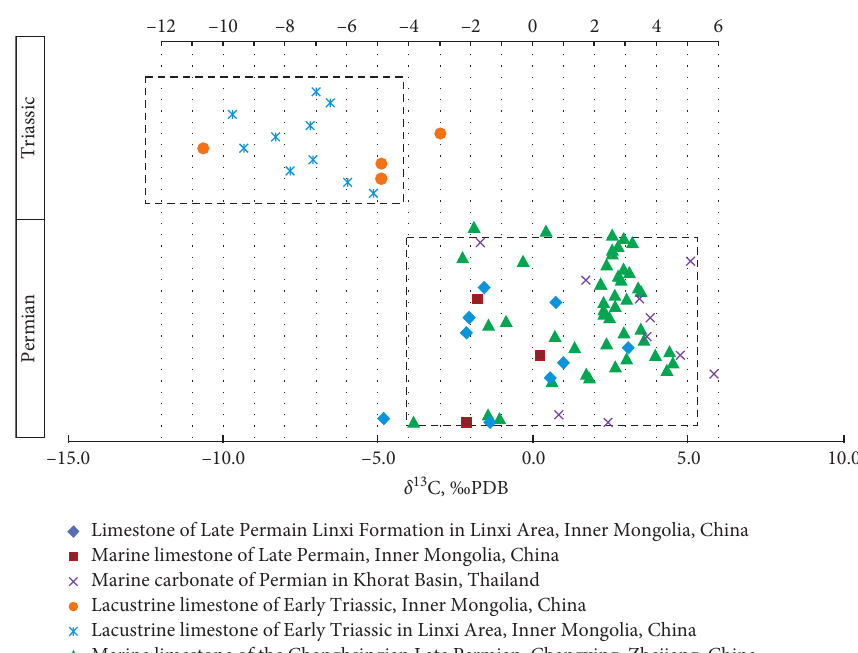
Figure 9: C isotopic compositions of the Linxi Formation limestone and the lacustrine limestone (Triassic) from the Linxi area in eastern Inner Mongolia and the comparison with the C isotopic of marine limestone (Permian) in the other areas of the